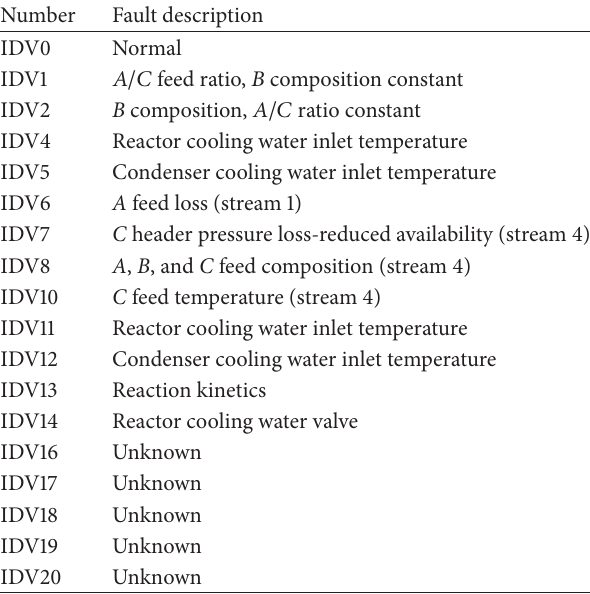
Table 4: Results of faults detection using PLS